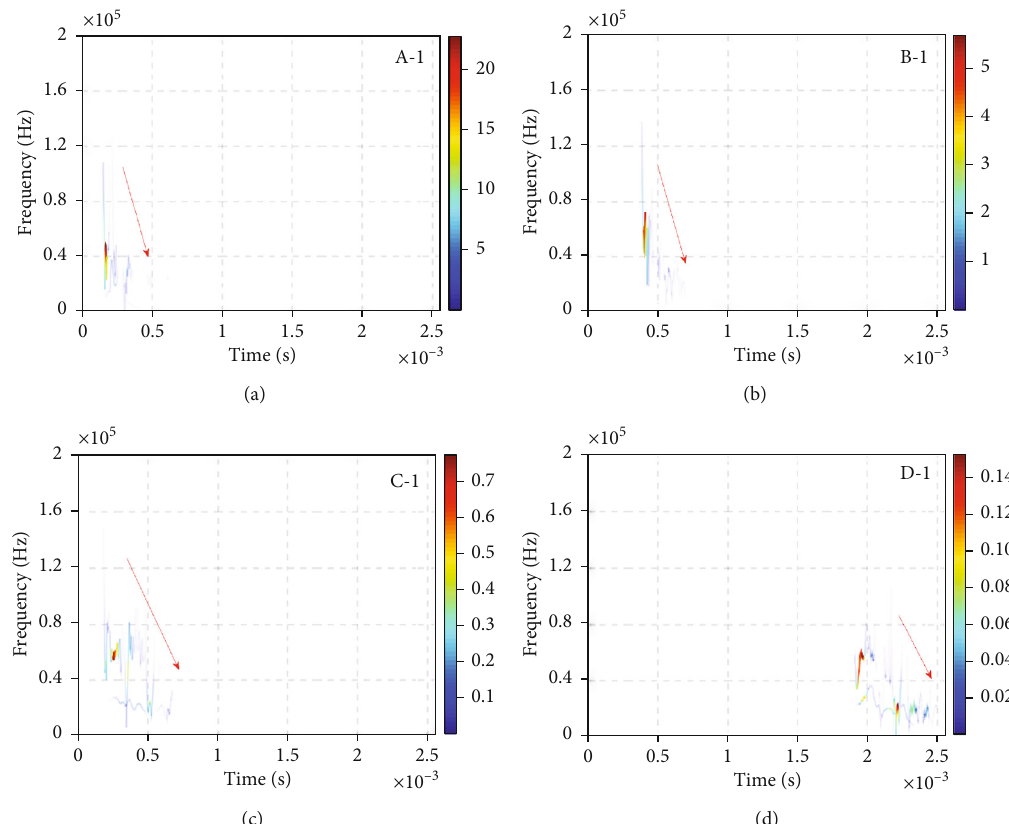
Figure 10: The Hilbert spectrum of samples with di ff erent water contents.